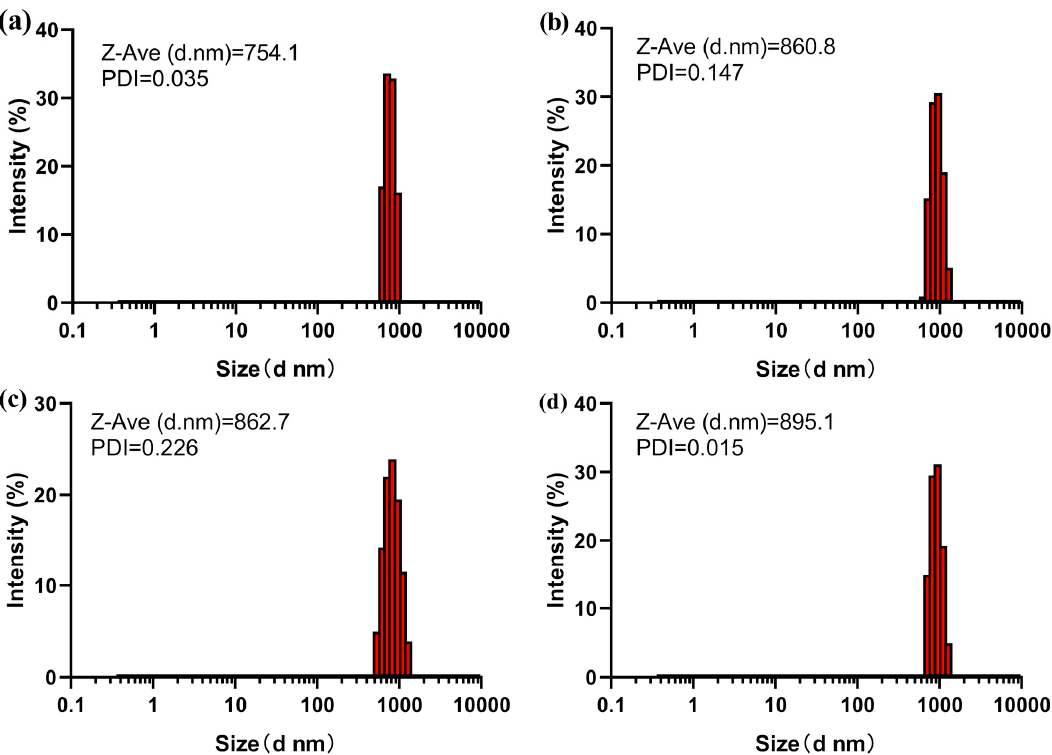
Figure 2. Size comparison of Cry3Aa and Cry3Aa-SmtA fusion crystals by dynamic light scattering (DLS). ( a ) Cry3Aa, ( b ) Cry3Aa-[SmtA], ( c) Cry3Aa-[SmtA] 3 , and ( d ) Cry3Aa-[SmtA] 6 . All samples were measured at a concentration of 100 μ g/mL of crystal.